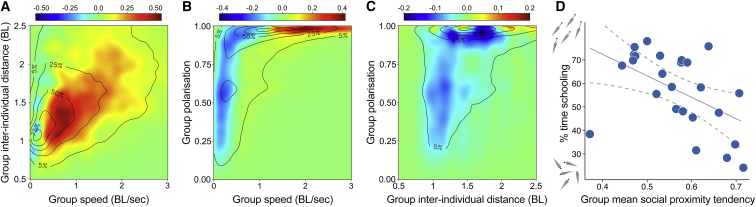
Group Structure and Movement Dynamics in Relation to Group Mean Social Proximity Tendency(A–C) Heatmaps showing the distribution and link between the three key components of collective motion for groups with a low mean social proximity tendency (n = 13) relative to groups with a high mean social proximity tendency (n = 12). Groups with a relatively high social proximity tendency were more likely to be found in the bluer regions of the plots, whereas groups with relatively low social proximity tendency were more likely to be found in the redder regions of the plots. Group speed depicts the mean median swimming speed of the individuals in a group and is qualitatively similar to the speed of the group centroid. Plots are based on frame-by-frame data at time steps of 1/24th s, with groups evenly allocated to two categories based on their mean social proximity tendency. Units are in mean body length (BL; 40.6 mm), and contours represent iso-levels in percentage of the highest bin for all groups combined; see Figure S2.(D) Proportion of time groups were schooling, characterized based on the raw distributions of group speed, cohesion, and polarization (see STAR Methods). Solid gray line and dashed gray lines indicate a linear fit to the data with 95% confidence intervals.